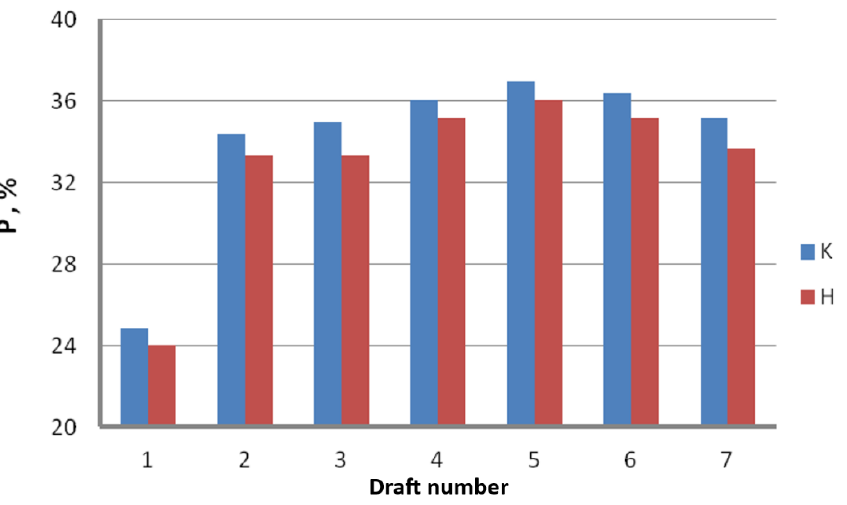
Figure 9. Percentage engine load P in respective drafts for the wires manufactured using conventional K and hydrodynamic H